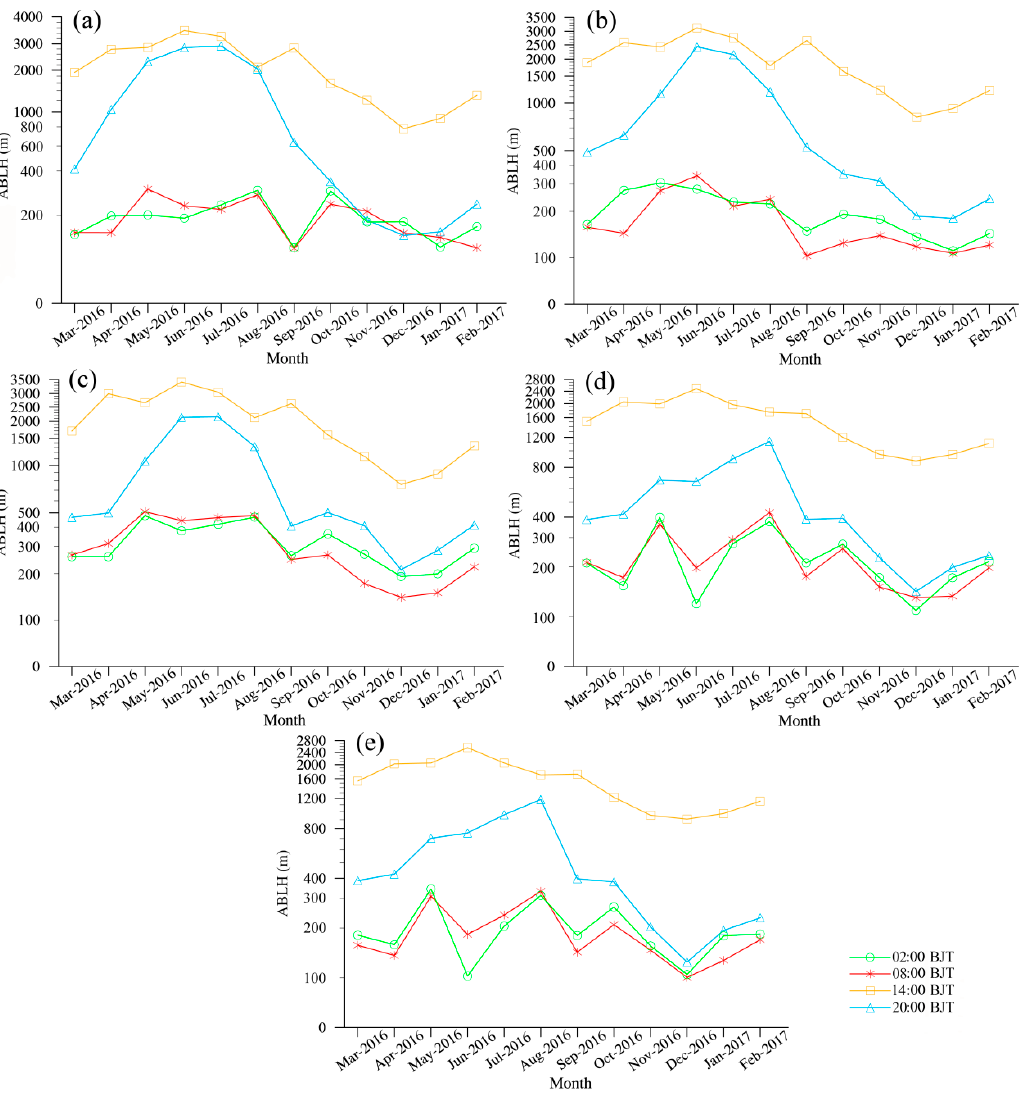
Figure 2. Monthly variation of the boundary layer height, four times per day, in the five representative areas: ( a ) Dunhuang, ( b ) Jiuquan (Suzhou District), ( c ) Minqin, ( d ) Yuzhong, and ( e ) Lanzhou. For the low atmospheric boundary layer height (Pblh) at 08:00 and 02:00 BJT, a non-equidistant Y-axis is used in the figure).